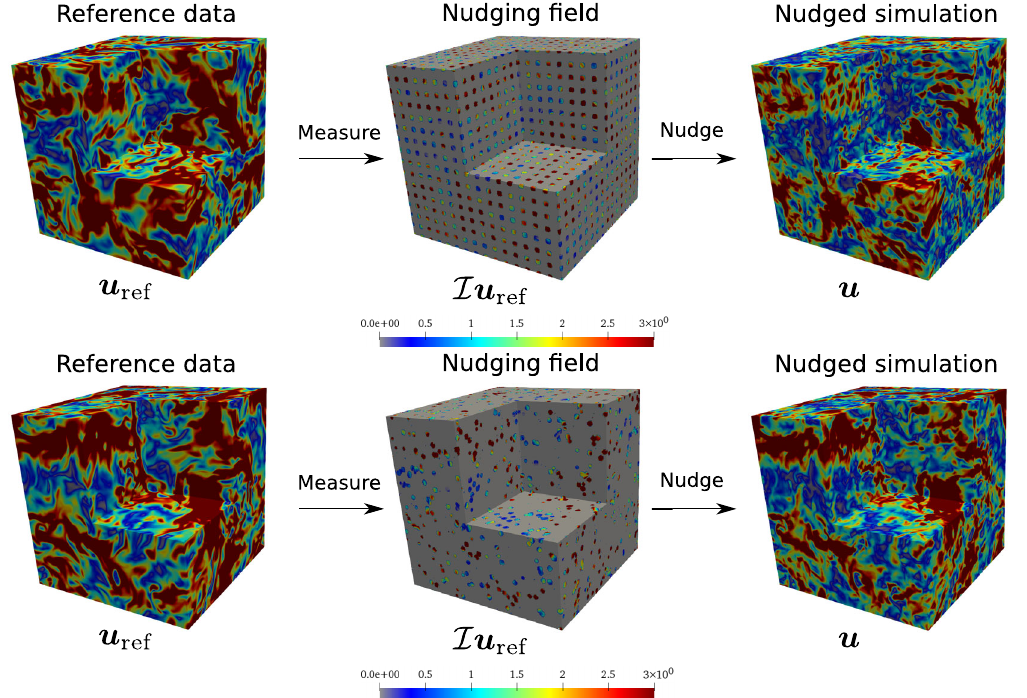
, and (right) nudged fields u for ref